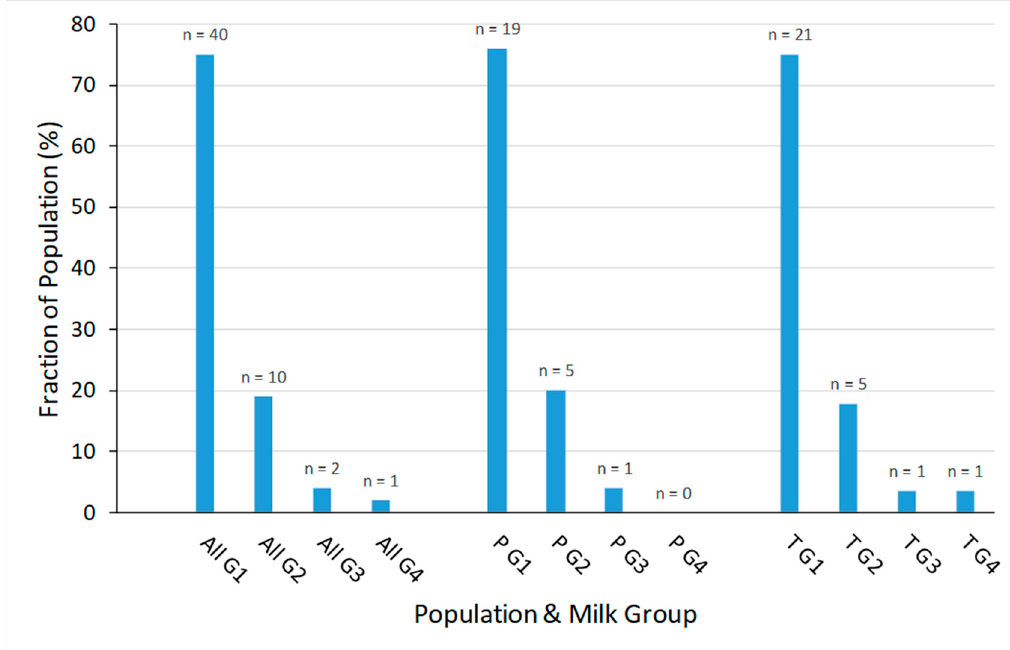
Figure 2. Distribution of milk groups in the different populations: All = all participants, P = participants with preterm infants, T = participants with term infants, G1 = milk group 1, G2 = milk group 2, G3 = milk group 3, G4 = milk group 4.